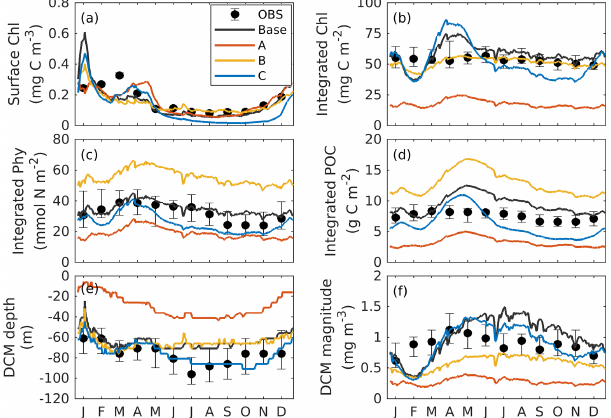
Figure 3. Annual cycle of surface chlorophyll (a) , vertically inte- grated chlorophyll (b) , vertically integrated phytoplankton (c) , ver- tically integrated POC (d) , and the depth (e) and magnitude (a) of the DCM from observations (black dots with error bars); the base case (black lines); and experiment A (orange lines; only satel- lite surface chlorophyll is used), B (yellow lines; satellite surface chlorophyll and float profiles of chlorophyll are used), and C (blue lines; all available observations are used). Chlorophyll, phytoplank- ton, and POC are integrated over the top 200m. Black error bars represent the interquartile range of